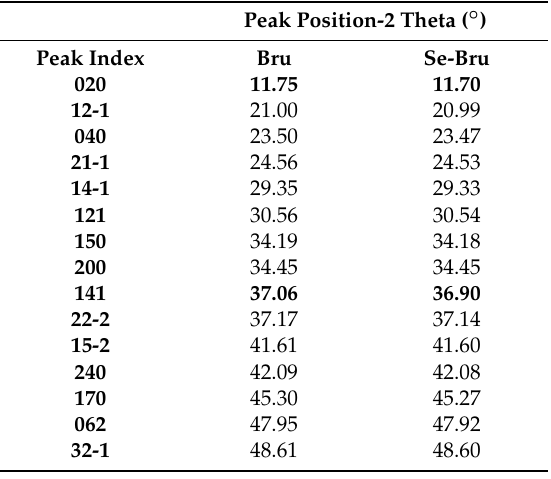
Table A1. Peak positions in PXRD diffractograms for the Bru and Se-Bru samples.